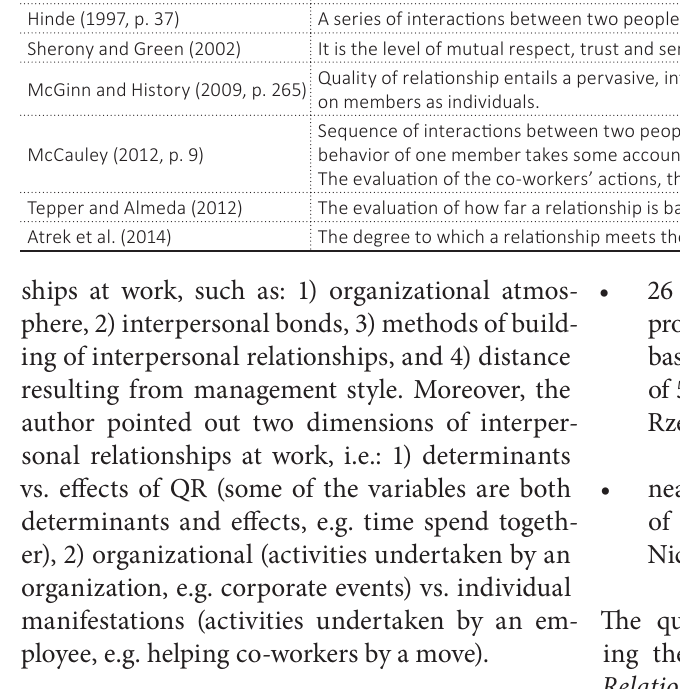
Table 1. Selected definitions and approaches to interpersonal relationships at work